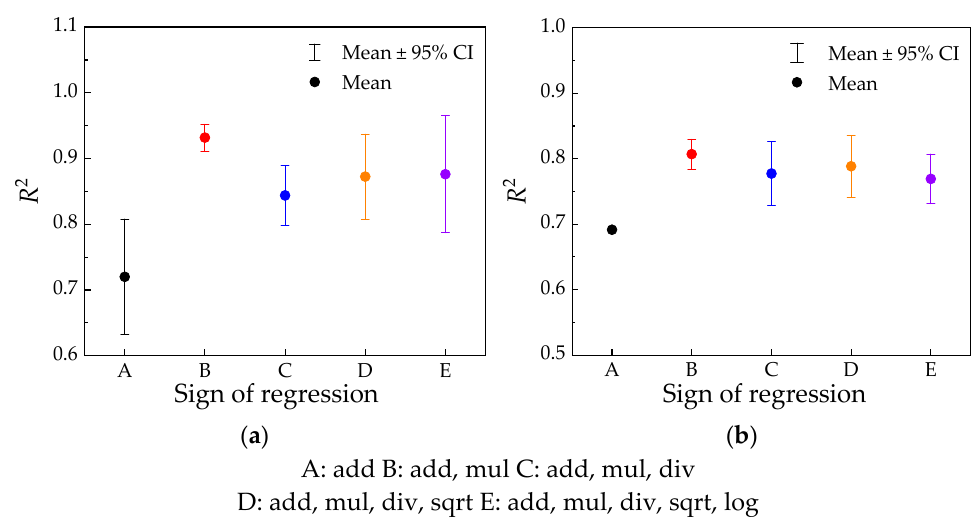
Figure 8. R 2 with different regression symbol settings: ( a ) the total thrust, ( b ) the total torque. Based on the above settings, the tunneling data from the Yin-Song Project are randomly divided into a training set and a test set at a ratio of 7:3. The total thrust and total torque are modeled based on the training dataset, and the calculated results are given by Equation (8). The R 2 of the thrust and torque models in the independent test dataset are 0.95 and 0.81, respectively. The measured and predicted values in the test set are compared in Figure 9. The serial number of the sample points in the figure is the number of sample points according to the construction sequence.